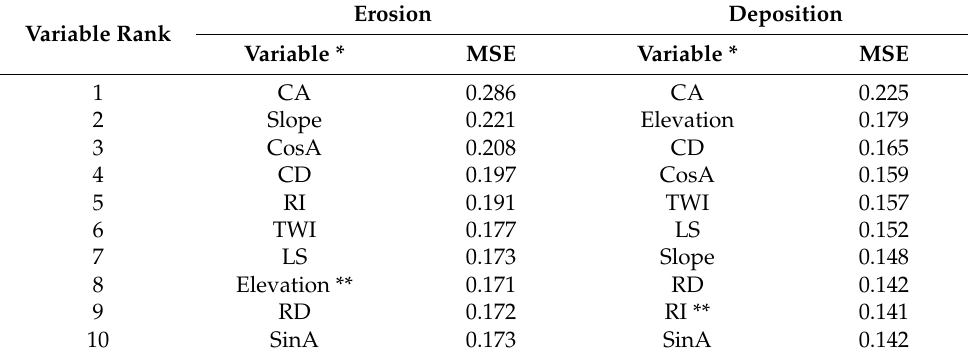
Table 4. Change of MSE as more variables are included in the